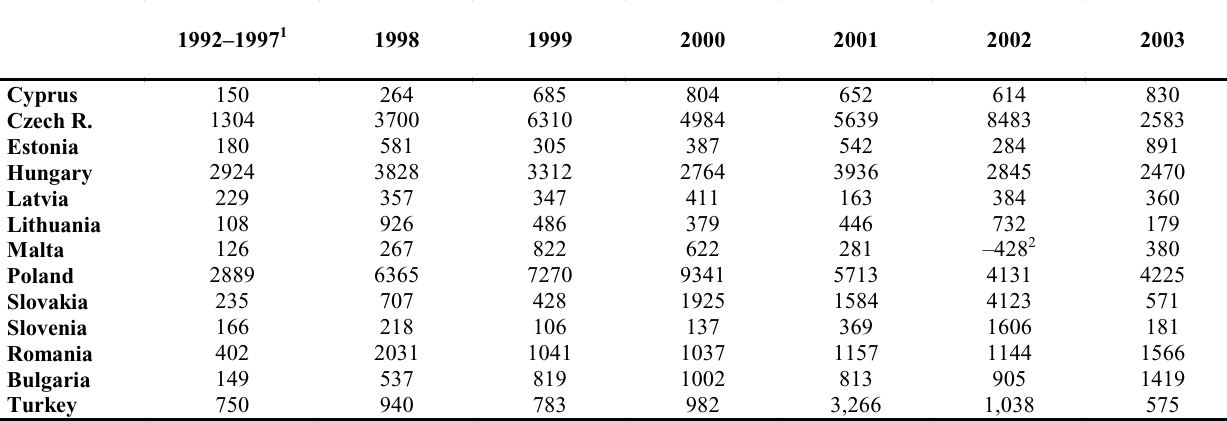
Table 5 . Comparison of Turkey with Romania, Bulgaria and the 10 new members of the EU in terms of FDI inflows between 1992 and 2003, million